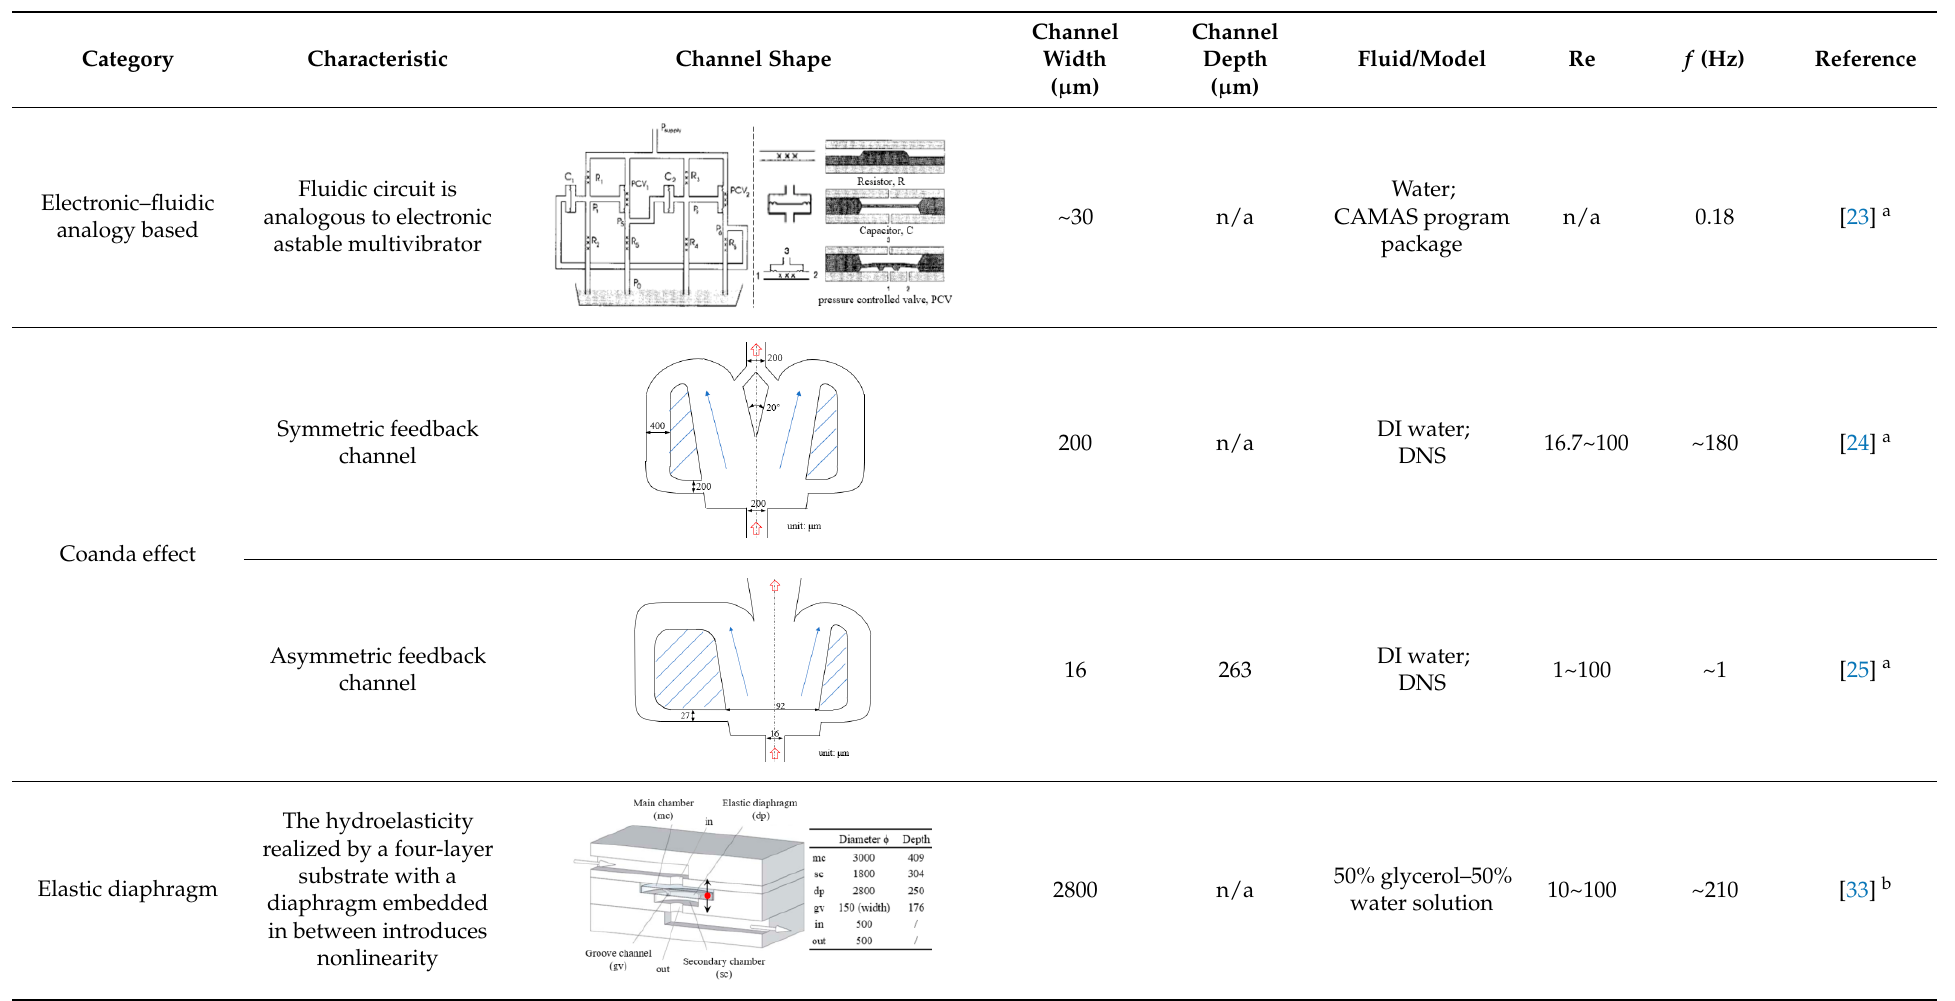
Table 1. Various fluidic oscillators based on different principles.